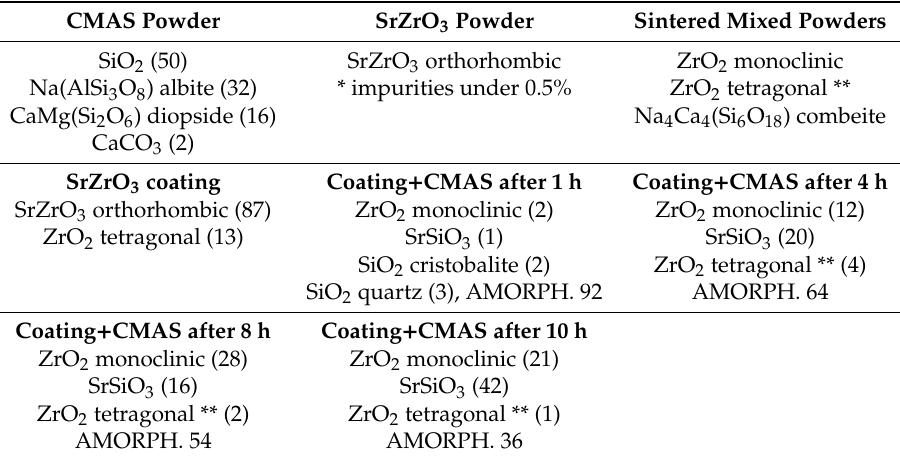
Table 2. XRD phases—semi-quantitative content (%).